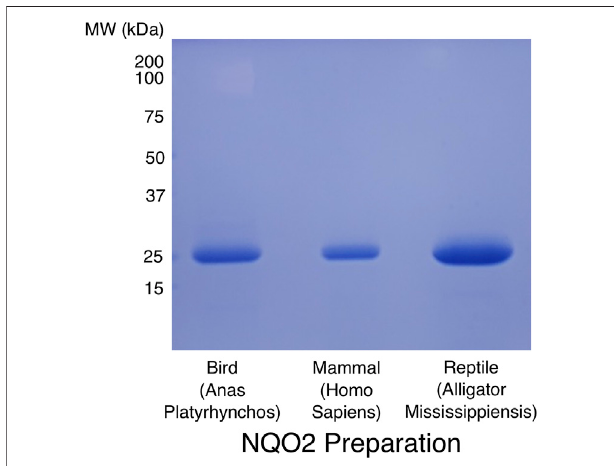
FIGURE4| SDS-PAGEanalysisofpuri fi edNQO2preparations.The fi nal preparations of NQO2 enzymes used for kinetic analyses were run on a 12% SDS-PAGE gel and stained with Coomassie brilliant blue R250. Codon- optimized coding sequences for NQO2 from Anas Platyrhynchos (predicted MR 26.7 kDa) and Alligator Mississippiensis (predicted MR 27.7 kDa)wereexpressedandpuri fi edusingthesameprotocoldevelopedfor the human enzyme (predicted MR 26.0 kDa; Leung et al., 2012). The proteins were expressed as hexa-histidine tagged constructs and puri fi ed using Ni 2+ - af fi nity chromatography, followed by removal of the af fi nity tag using TEV protease, anion exchange chromatography, and gel fi ltration